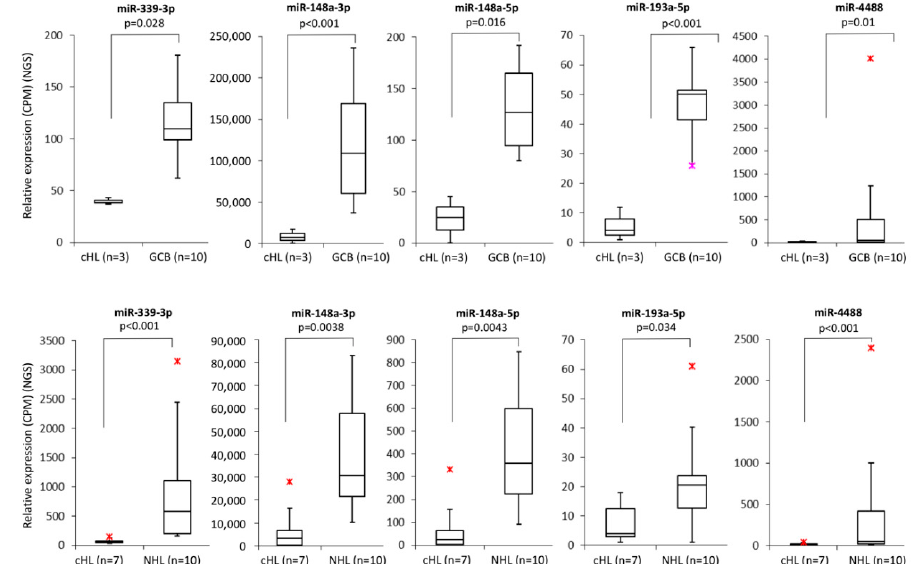
Figure 1. Expression of miRNAs (mir-339-3p, mir-148a-3p, mir-148a-5p, mir-193a-5p and mir-4488) which promoter regions are located within or up to 1000 bp upstream from a CpG island, downregulated in cHL cell lines ( n = 7) in comparison to NHL cell lines ( n = 10) (based on NGS sequencing, p < 0.05, upper panel). Expression of miRNAs (mir-339-3p, mir-148a-3p, mir-148a-5p, mir-193a-5p and mir-4488) which promoter regions are located within or up to 1000 bp upstream from a CpG island, downregulated in cHL cell lines ( n = 3) in comparison to sorted GCB 77 + from tonsillectomy specimens of chronic hyperplastic tonsillitis ( n = 10) (based on NGS sequencing, p < 0.05, lower